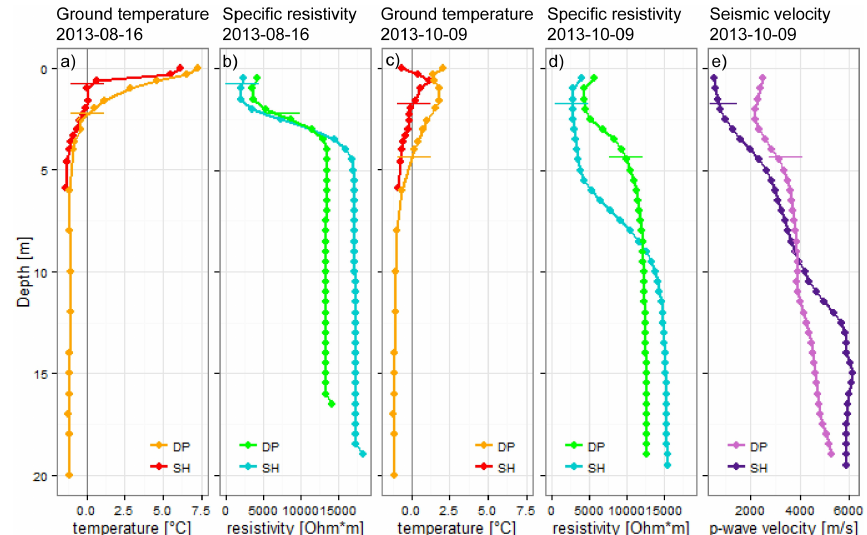
Figure 10. Vertical distribution of specific resistivity and P wave velocity at the borehole locations, extracted from the tomograms shown in Fig. 9, as well as borehole temperatures for the dates of the ERT and RST measurements. The horizontal lines represent the active layer thickness at the respective time